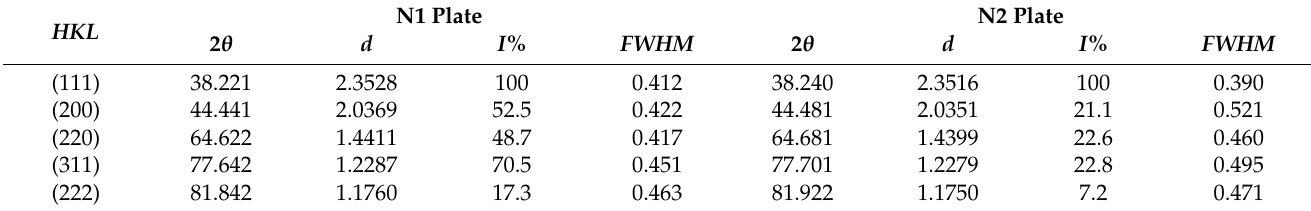
Table 2. Diffraction peak correlation parameters of annealed 1561 aluminum alloy under different deformation